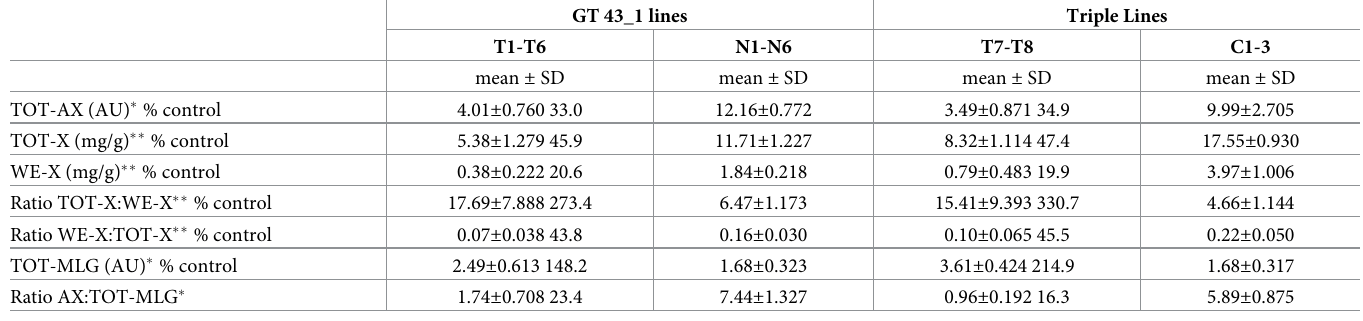
Table 2. Amounts of arabinoxylan and β -glucan (MLG) detected in the GT43_1 single and Triple RNAi lines compared to their respective null and control lines.